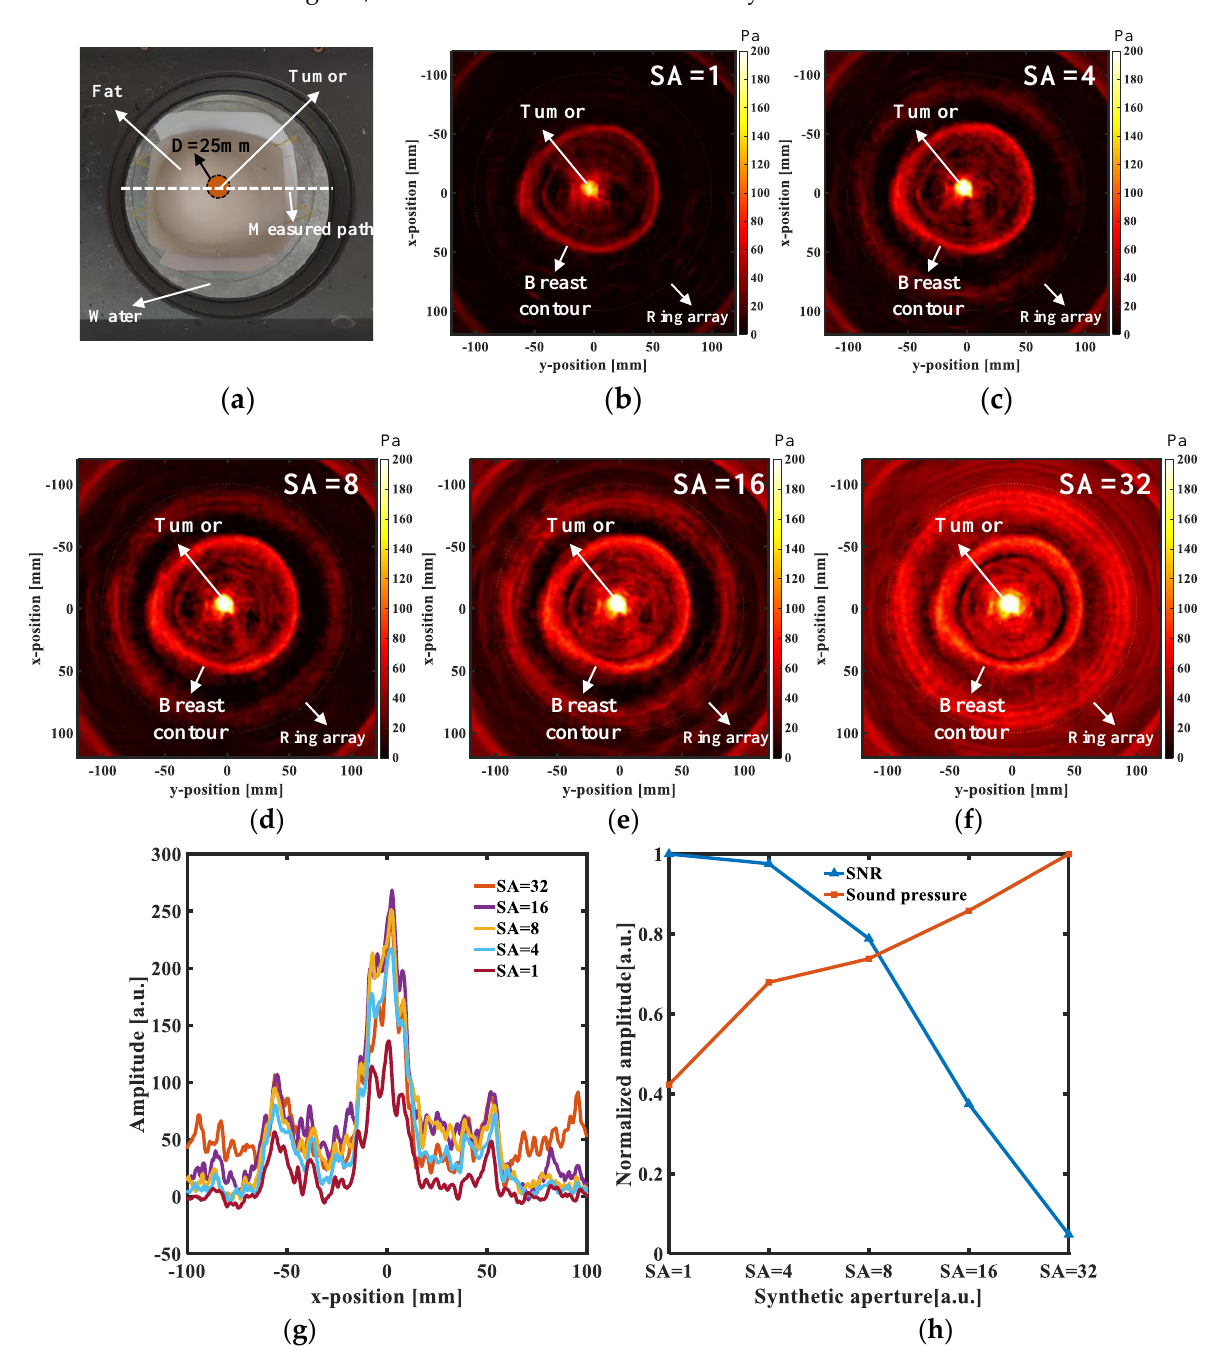
highest, which is consistent with the theory.